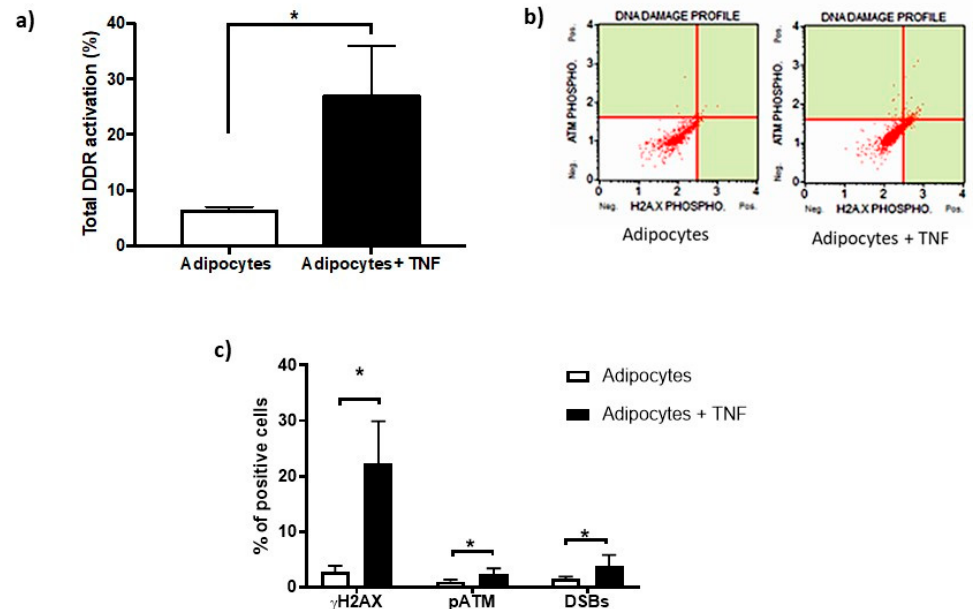
Figure 4. DNA Damage Response (DDR) activation basal and after-TNF α treatment. ( a ) Percentage of DNA damage response activation in adipocytes induced by TNF α (125 ng/mL, 24 h), three independent experiments with experimental replicate were carried out. Student t test * p < 0.05. ( b ) The capture of representative cytofluorometry analyzes as images that show γ H2AX in X-axis, pATM in Y-axis. DSBs corresponds to the upper right signal, this means double stain. ( c ) Percentage of positive cells distribution as part of DNA damage response showing the TNF α effects. One-way ANOVA test * p < 0.05.